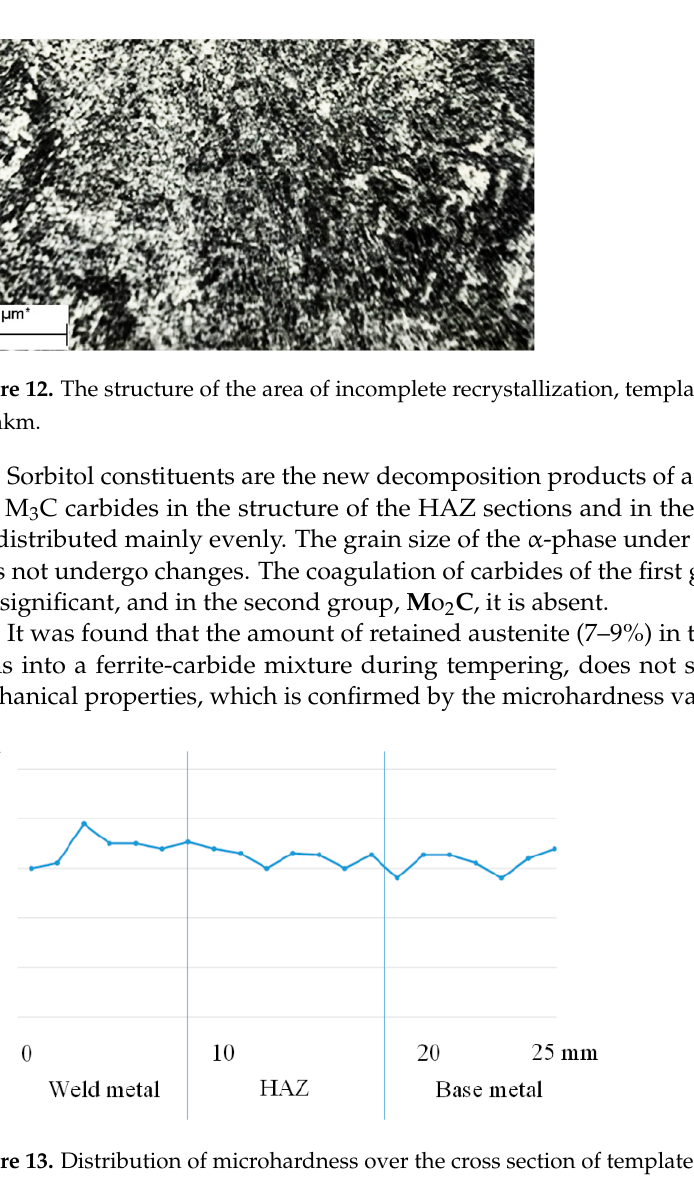
Figure 11. Structure of the overheating section, template 2 (Figure 7). ×400. *—mkm.